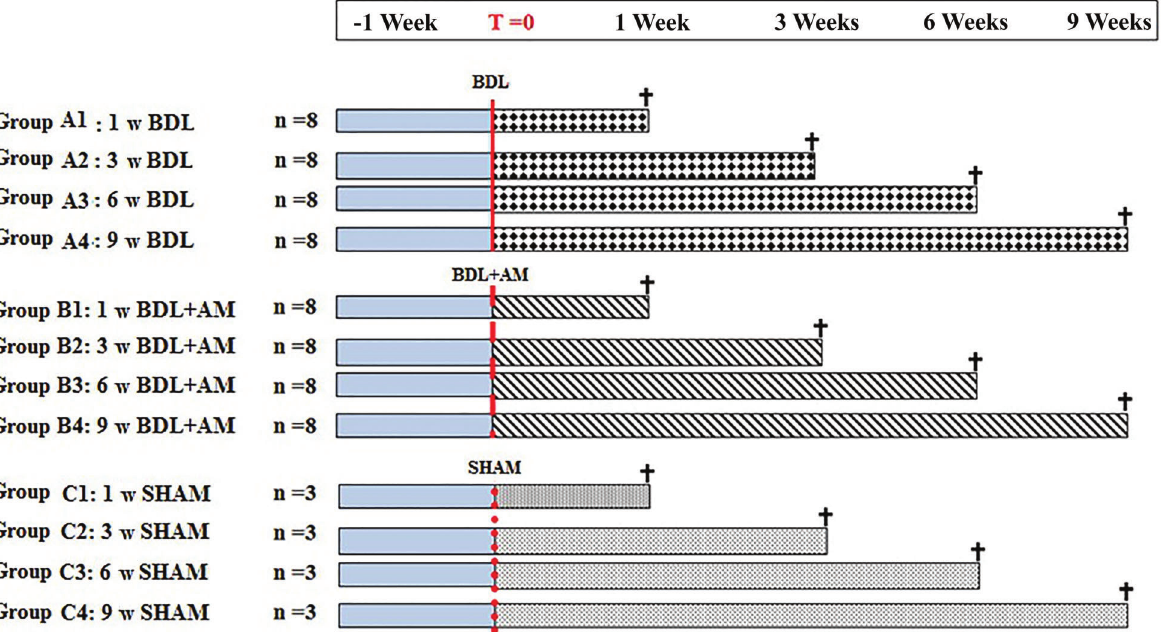
Figure 1. Experimental design. In blue: Period of acclimatization; BDL: bile duct ligation; AM: amniotic